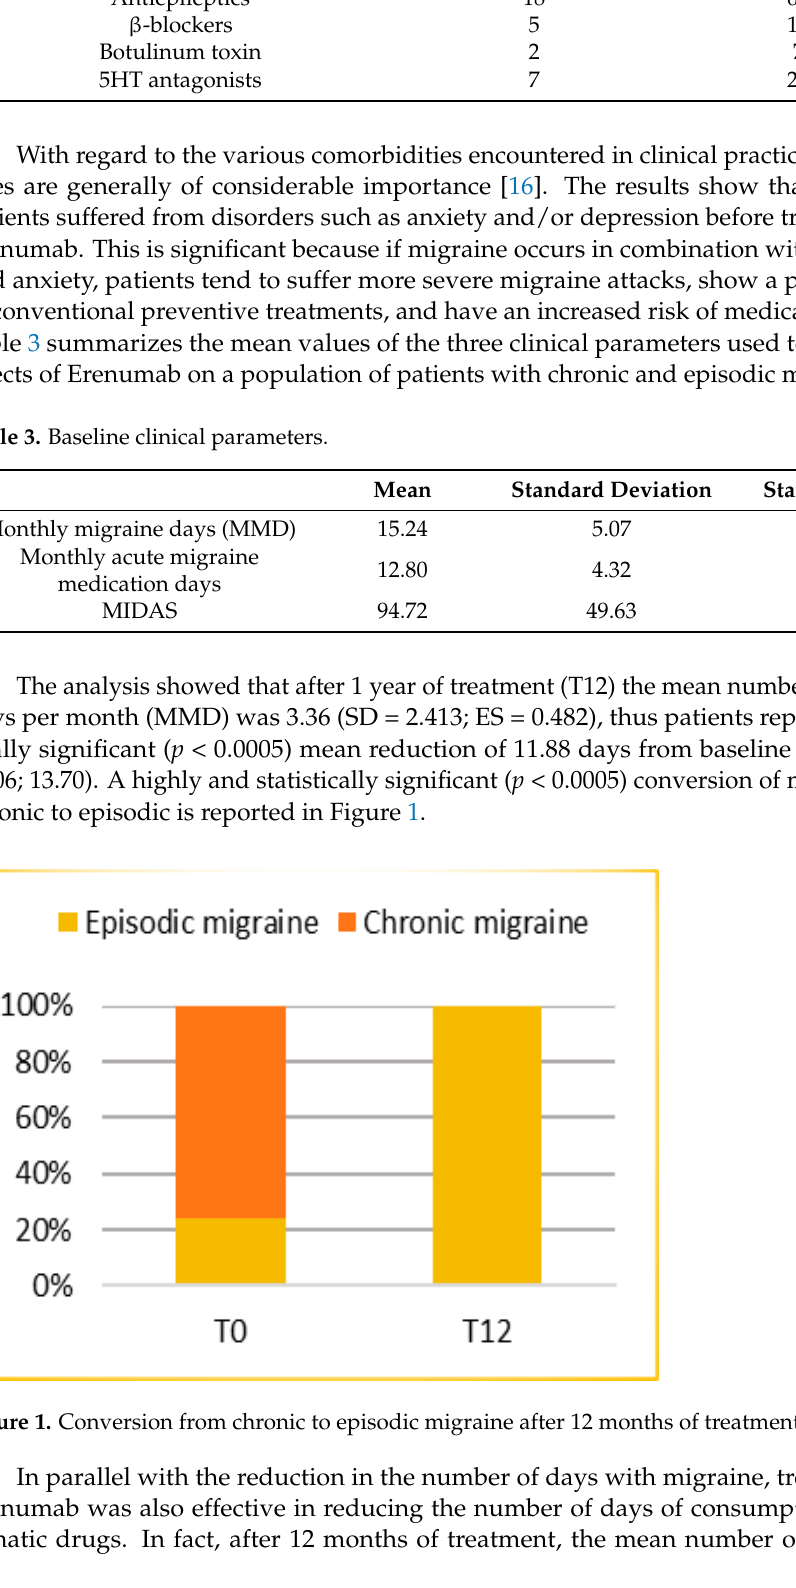
Table 2. Prior preventive treatment failure.